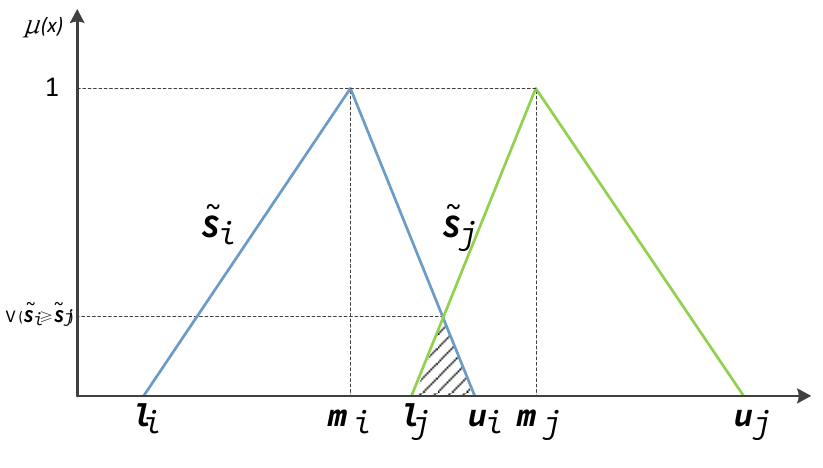
Figure 2. Degree of probability of (cid:101) S i ≥ (cid:101) S j